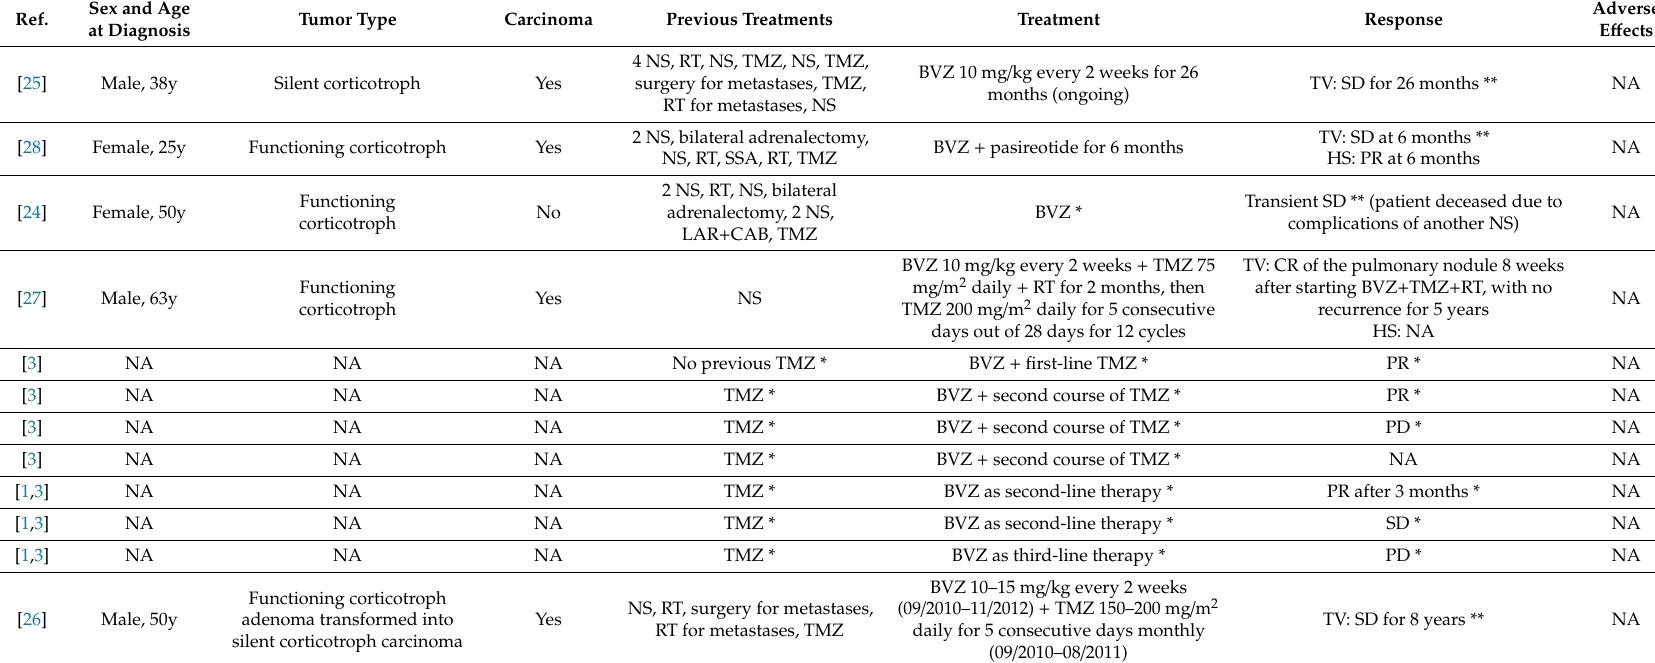
Table 2. Cases of aggressive pituitary neuroendocrine tumors and pituitary carcinomas treated with VEGF-targeted therapy.